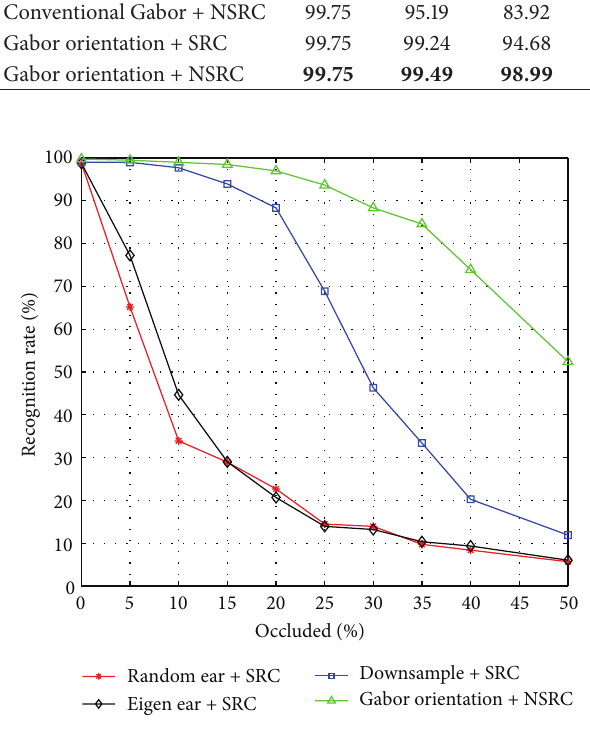
Figure 9: Ear recognition rates on USTB ear database III with various levels of random occlusion.